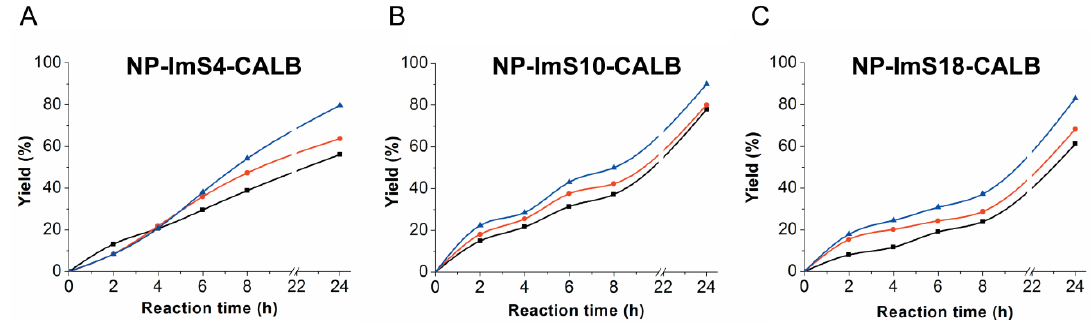
Figure 5. Influence of the transesterification reaction time on the yield of FAMEs production at different temperatures: 27 °C (black line), 32 °C (red line) and 37 °C (blue line) for each of the immobilized systems: ( A ) NP-ImS4-CALB, ( B ) NP-ImS10-CAL-B and ( C ) NP-ImS18-CALB.